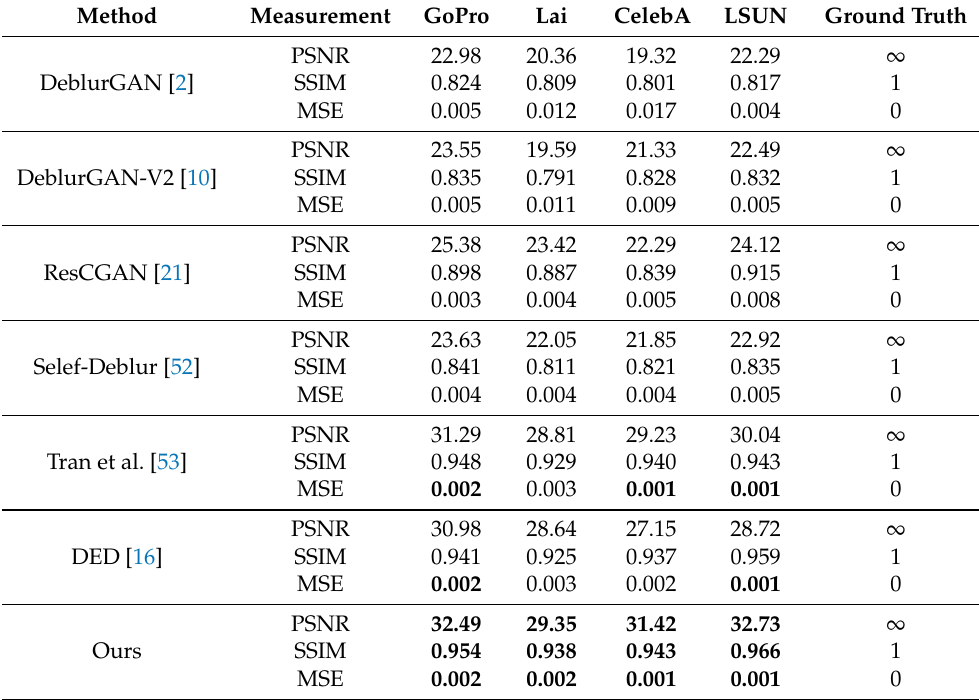
Table 1. Quantitative comparisons evaluated on different datasets with different methods. The best measurements for each of the datasets are in